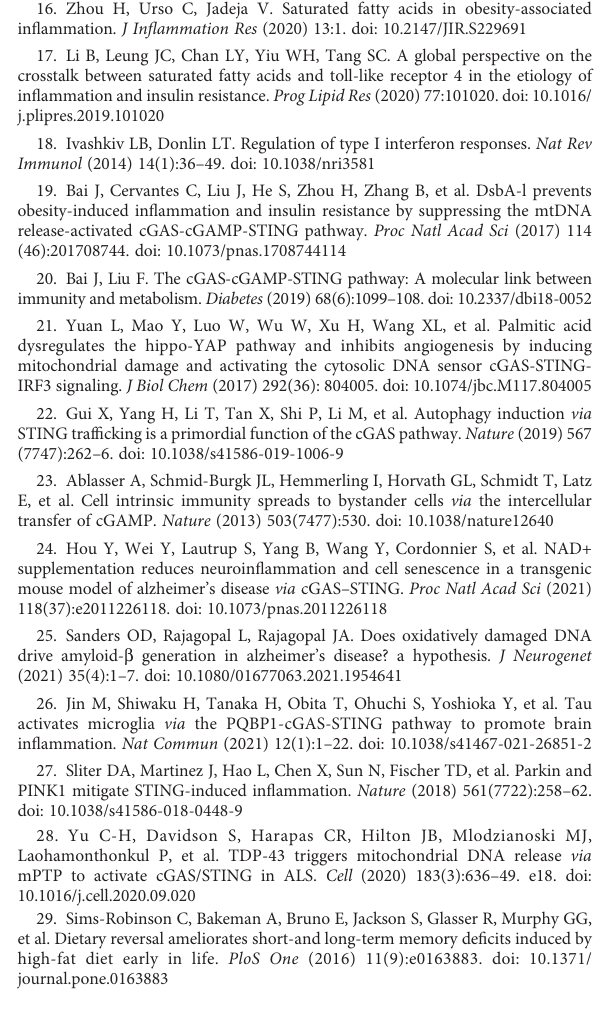
SUPPLEMENTARY FIGURE 8 Representative hippocampal cGAS/STING western blot images. Representative unaltered images of western blots quanti fi ed in main fi gure 4 (w/link color) for hippocampal cGAS/STING pathway protein expression of cGAS (A) , STING (B) , pIRF3 (C) , IRF3 (D) , NF kb (E) , and tubulin (F) in male BL/6 mice fed standard diet (SD) or high fat diet (HFD).